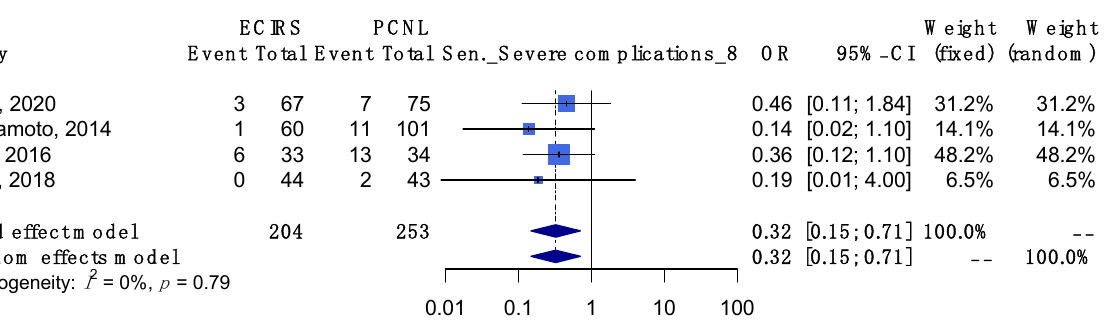
Figure A31. Sensitivity analysis of outcome regarding severe complications. ([17–19,22])